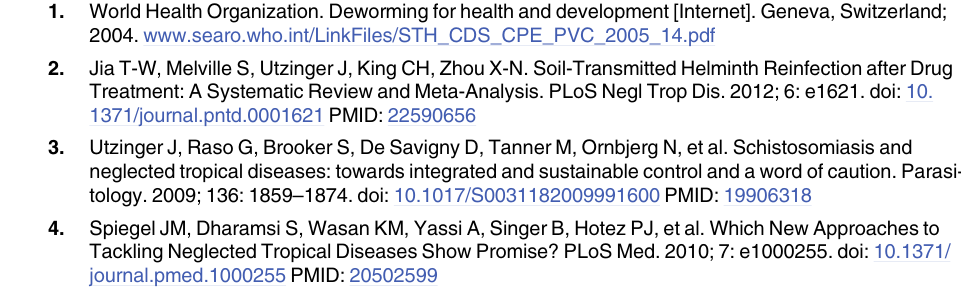
S1 Table. Prevalence ratios for improved vs. hygienic latrine access. S2 Table. Means of each variable used in the principal components analysis by quintile of the index. S3 Table. Missing observations for outcome, exposure, and confounder variables. S4 Table. Association between SHEWA-B participation and STH